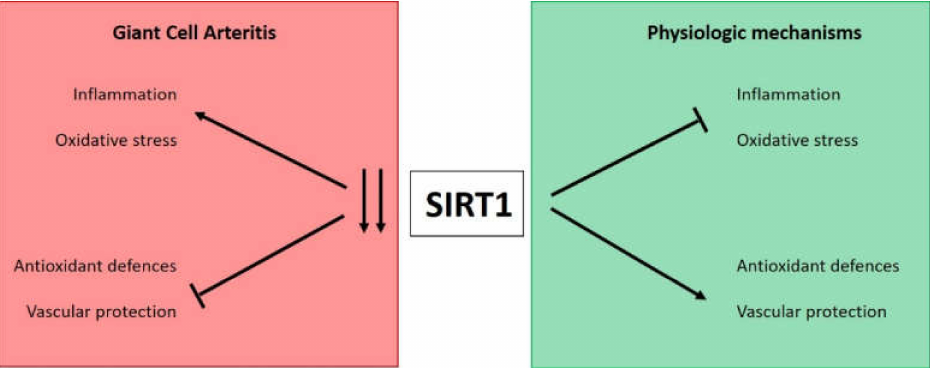
Figure 4. Schematic diagram illustrating the possible effects of SIRT1 downregulation in